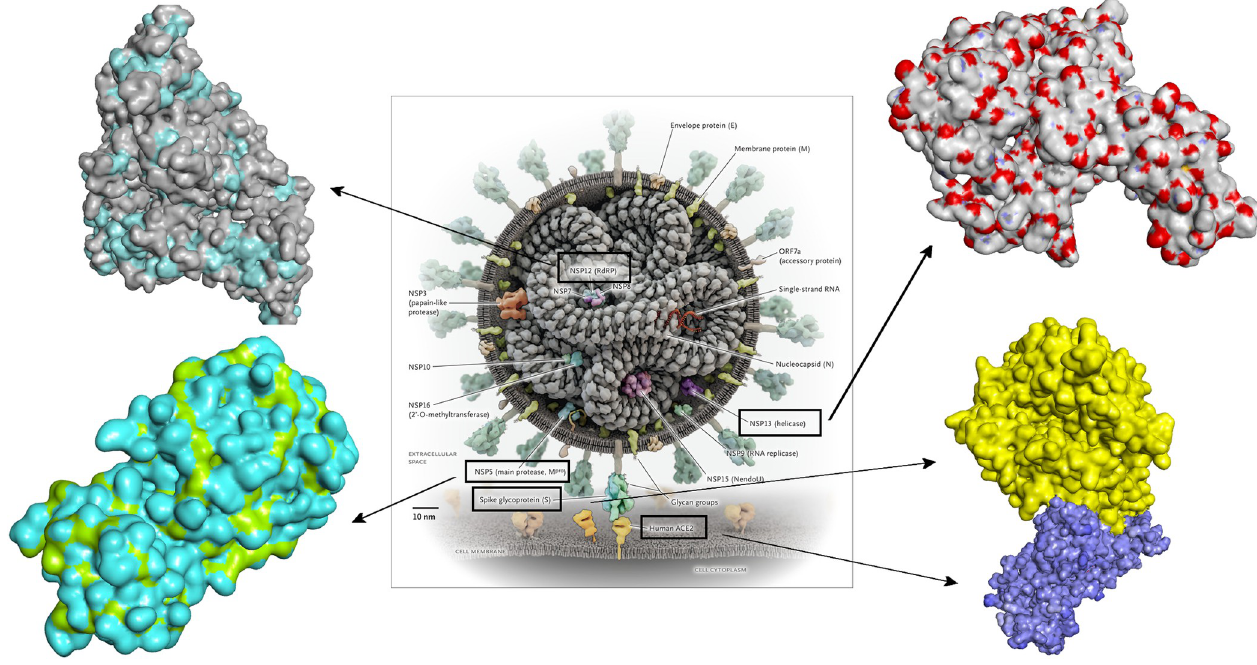
Fig 4. SARS-CoV-2 virion with the four selected proteins. The structure of virion is taken from [40].